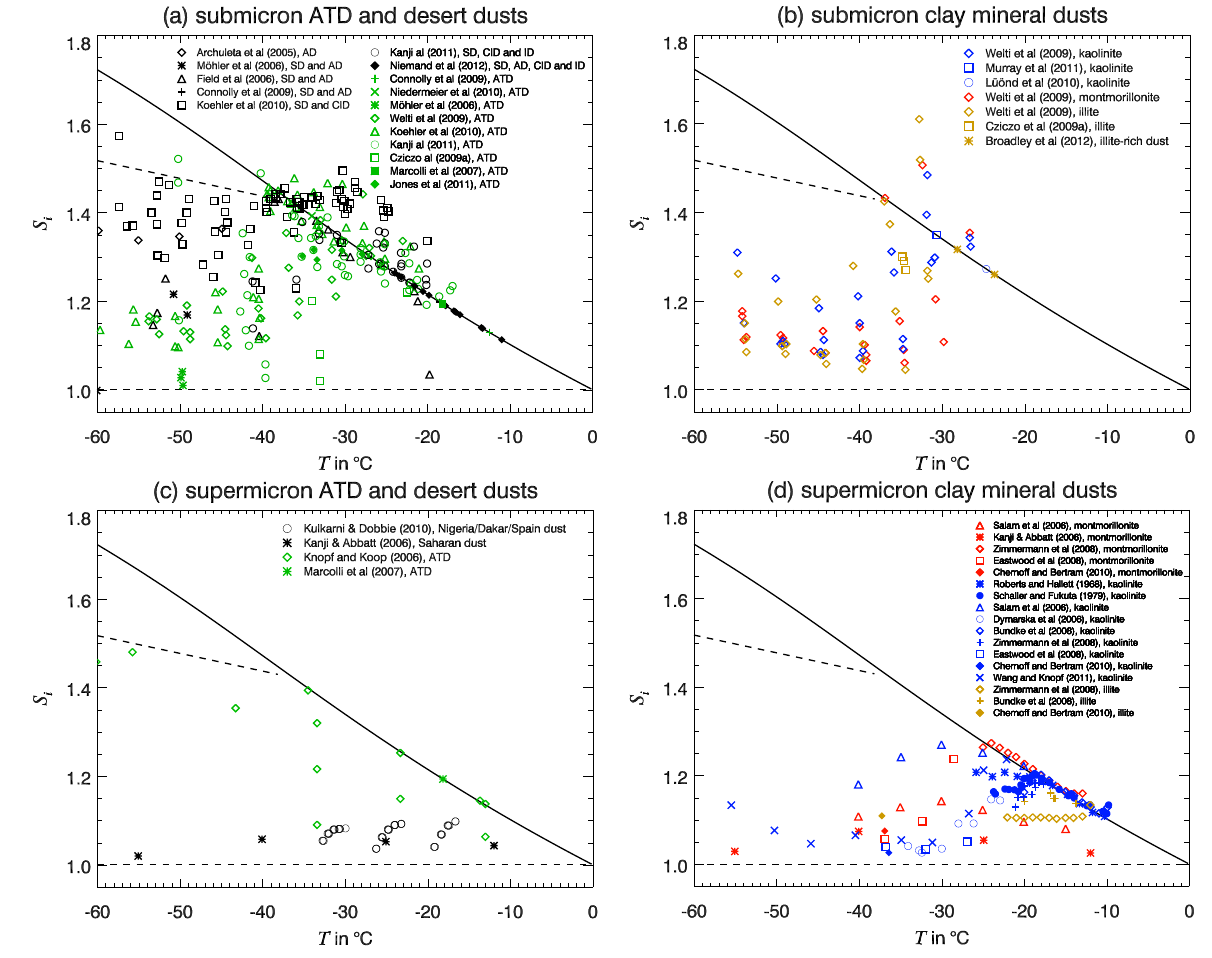
Fig. 3. Ice nucleation onset temperatures and saturation ratios for mineral dust particles.